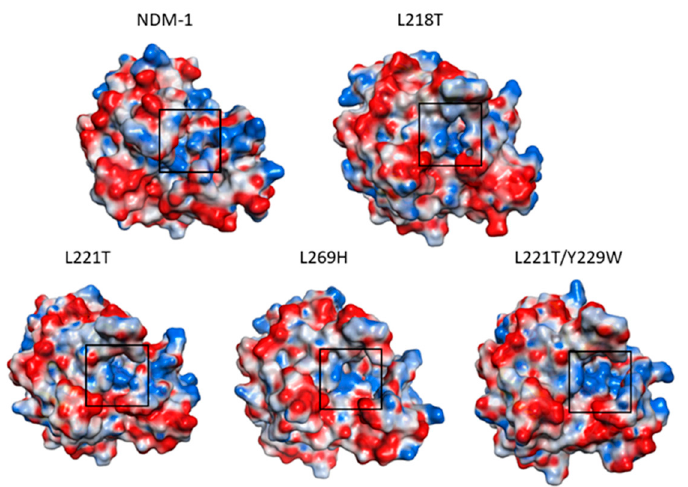
Figure 4. Electrostatic surface of all proteins: anionic surface in red, cationic surface in blue and neutral surface in white.